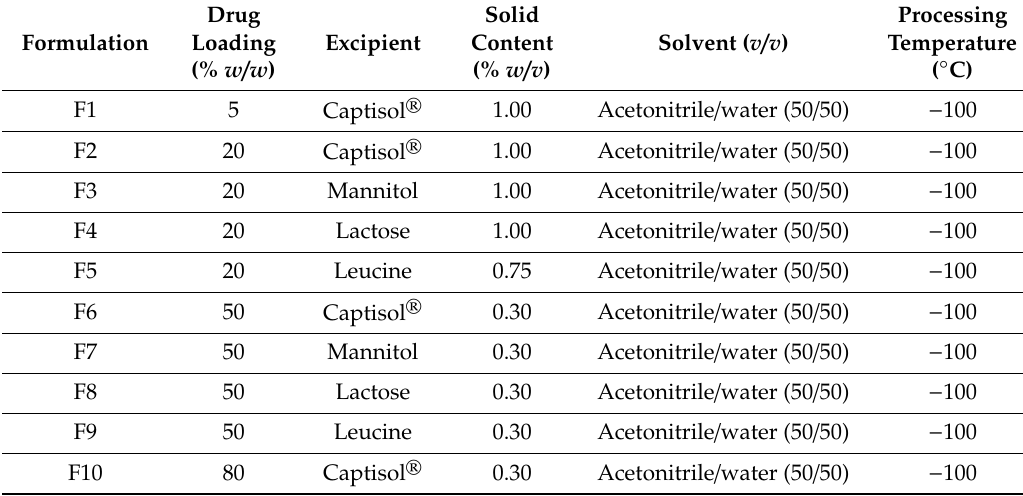
List of thin film freezing (TFF) remdesivir compositions and parameters used for their